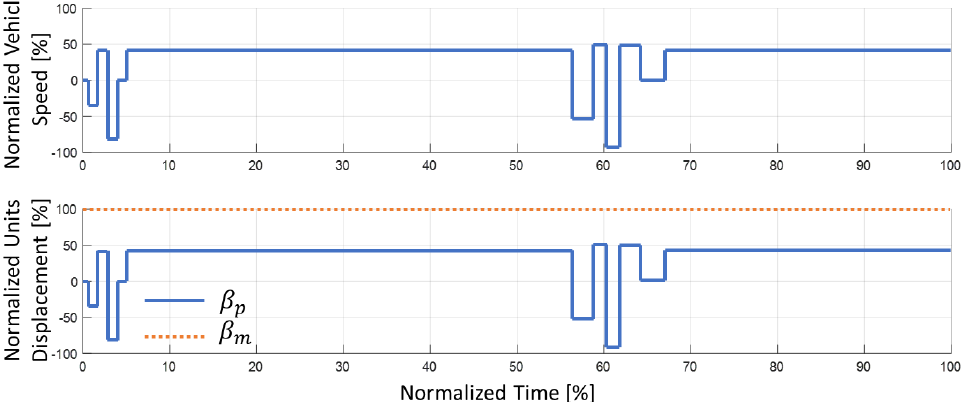
Figure 17. Conceptual Drive Cycle of Vehicle Speed and Unit Displacement.